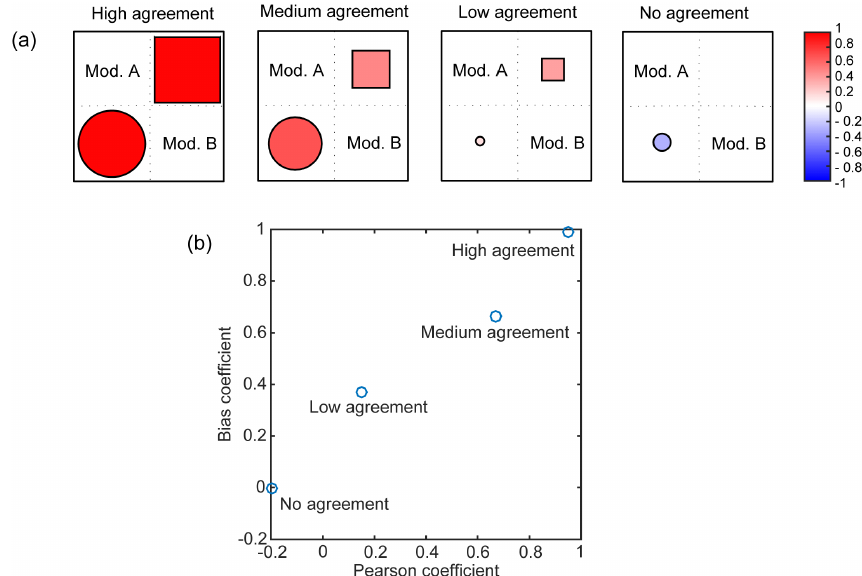
Figure 3. (a) Example of a matrix picture between two models A and B. Correlation values ( − 1 ≤ r ≤ 1) are represented with circles below the diagonal, while bias (0 ≤ α ≤ 1) is plotted as squares above the diagonal. The size and color of symbols are proportional to the coefficient values. White (blank) matrix entries correspond to r = 0 or α = 0. (b) Scatterplot corresponding to the four cases shown in panel (a) .